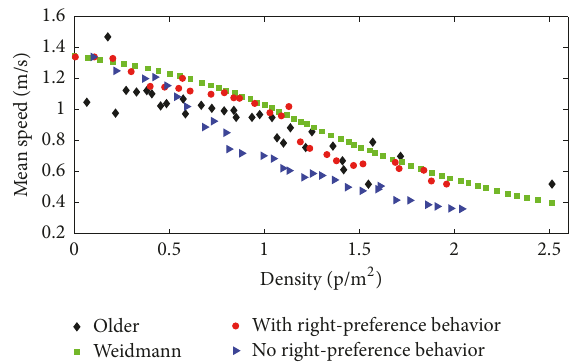
Figure19:Fundamentaldiagramcomparingdata.Inthesimulation, 𝜙 = 1 and 𝜆 = 0.2 m. For comparison with the actual empirical data, we take the desired speed of pedestrian V 0 𝑖 = 1.34